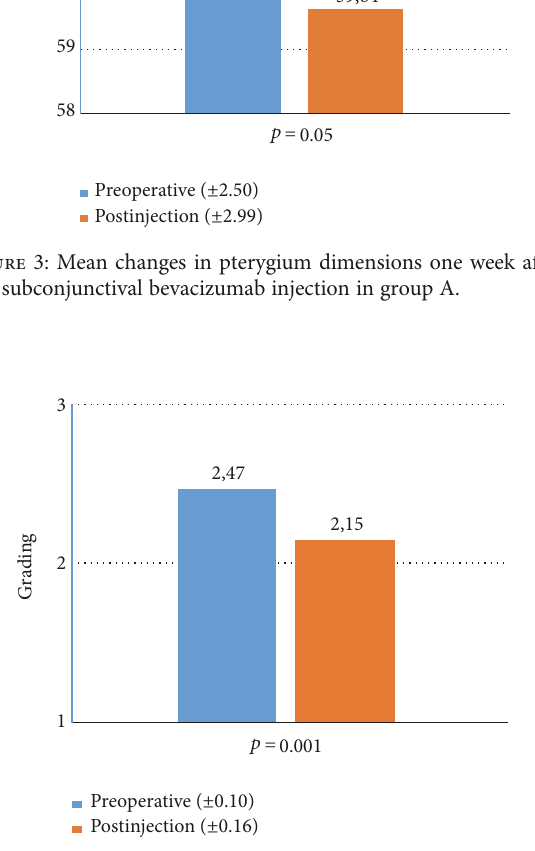
Figure 4: Mean changes in pterygium grading 1 week after fi rst subconjunctival bevacizumab injection in group A.